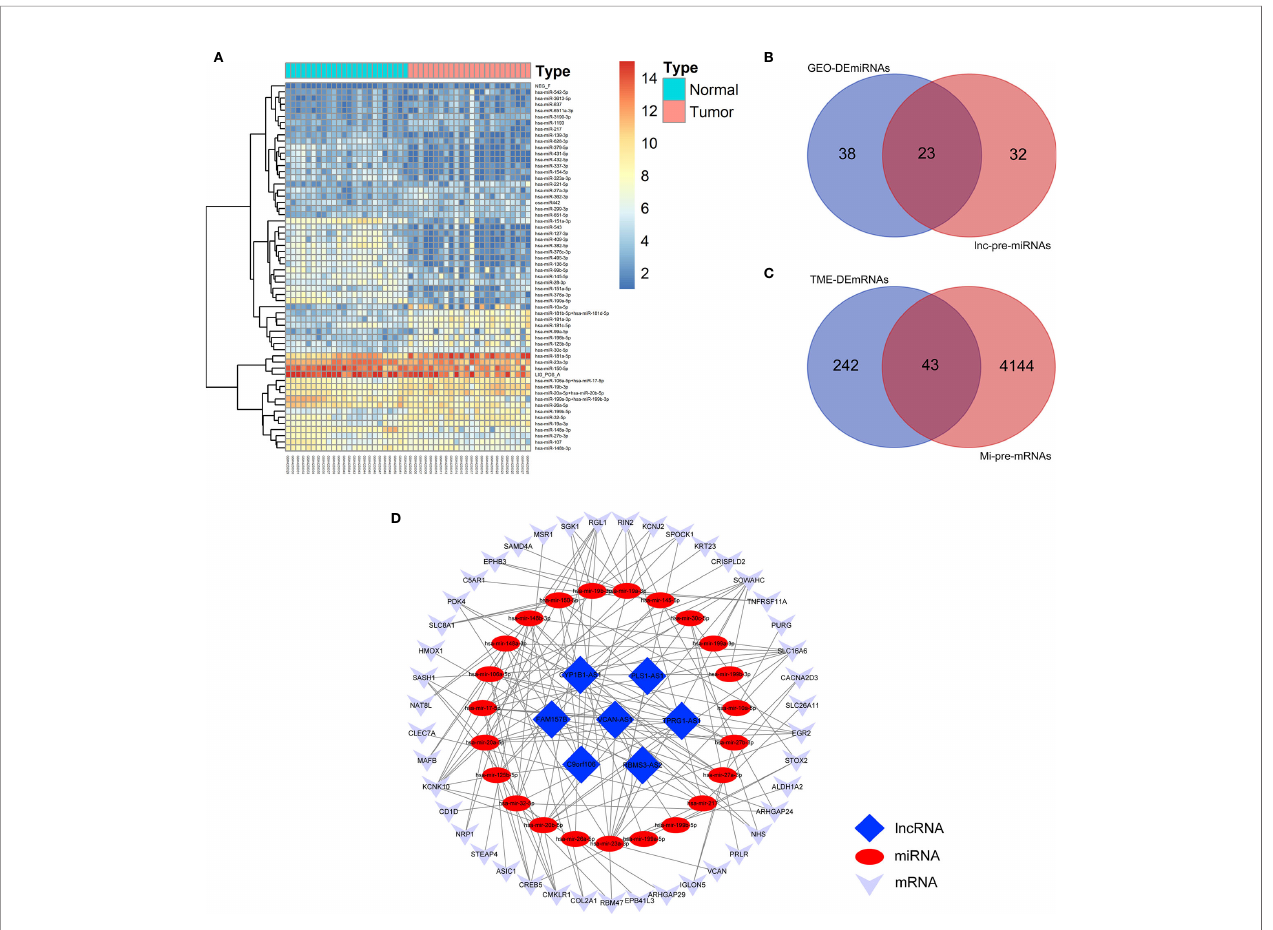
FIGURE 4 | Construction of TME-related ceRNA network. (A) Heatmap of DEmiRNAs between AML and normal control samples in GSE142699 microarray. (B) Venn diagram of the intersecting miRNAs between DEmiRNAs and lnc-pre-miRNAs. (C) Venn diagram of the intersecting of mRNAs between mi-pe-mRNAs and TME- related DEmRNAs, a total of 43 common mRNAs. (D) Preliminary establishment of TME-related ceRNA network, including 43 mRNAs, 23 miRNAs, and 7 lncRNAs.